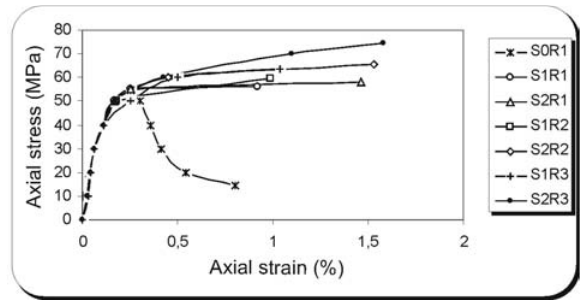
Fig. 7. Stress-strain curves (effect of corner radius)